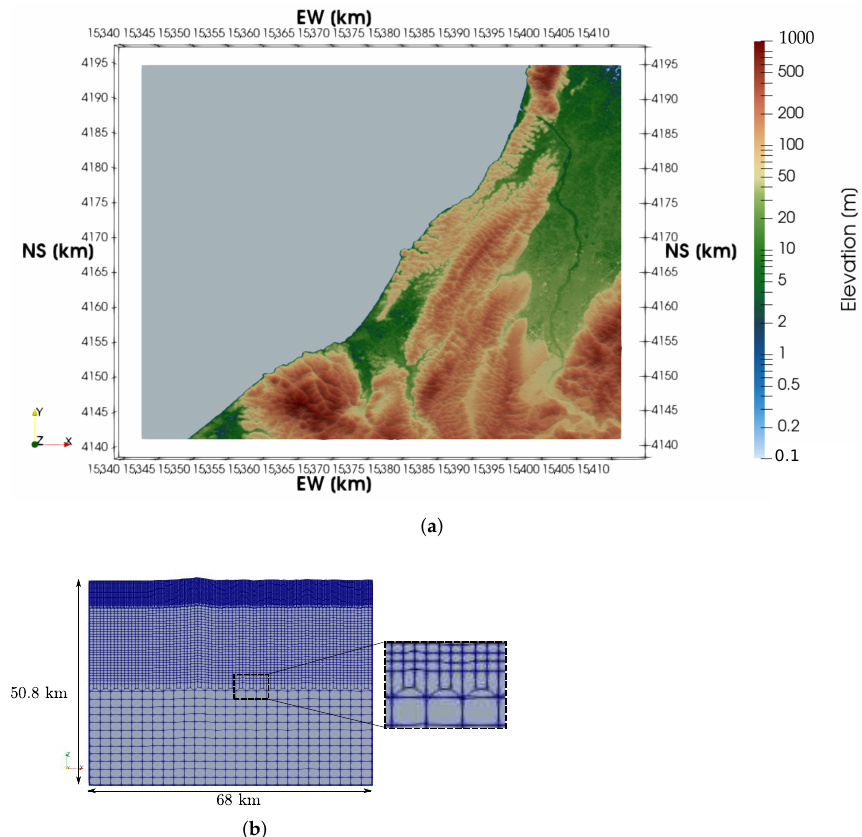
Figure 6. Example of Digital Elevation Model including bathymetry line of the Niigata region (Japan) and hexahedral mesh obtained by Hexmesh code. ( a ) Digital Elevation Model (DEM) of the Niigata area (Japan); ( b ) Mesh of the Niigata area, with detail on the transition elements (reprinted from